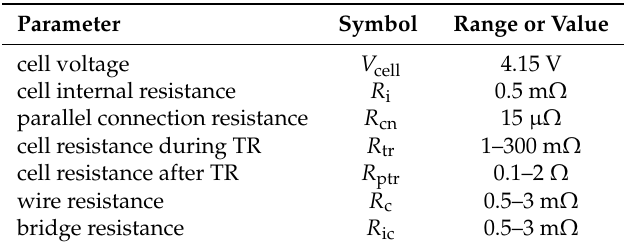
Table 1. Start parameter set used in the equivalent circuit model (ECM) in Figure 5 and their estimation ranges or set values for the parameter